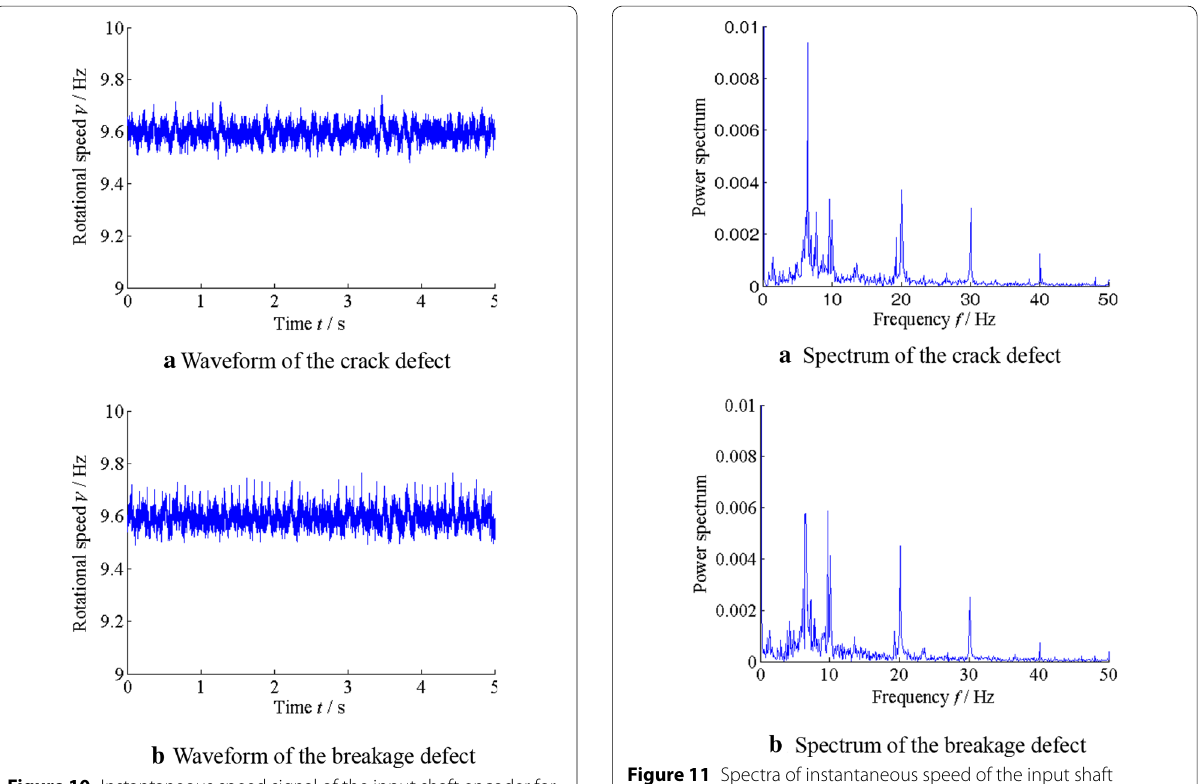
Figure 10 Instantaneous speed signal of the input shaft encoder for localized defects